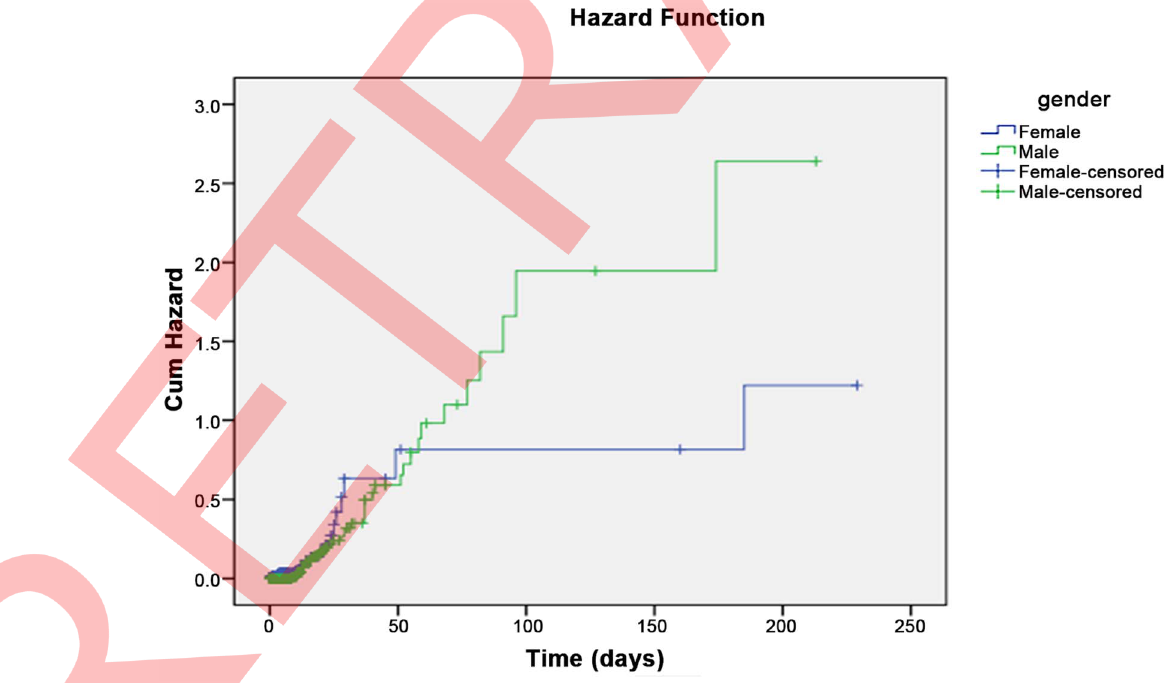
Figure 3. Plot of the Cumulative Hazard function for the data to test the assumption of Cox Proportional Hazard.